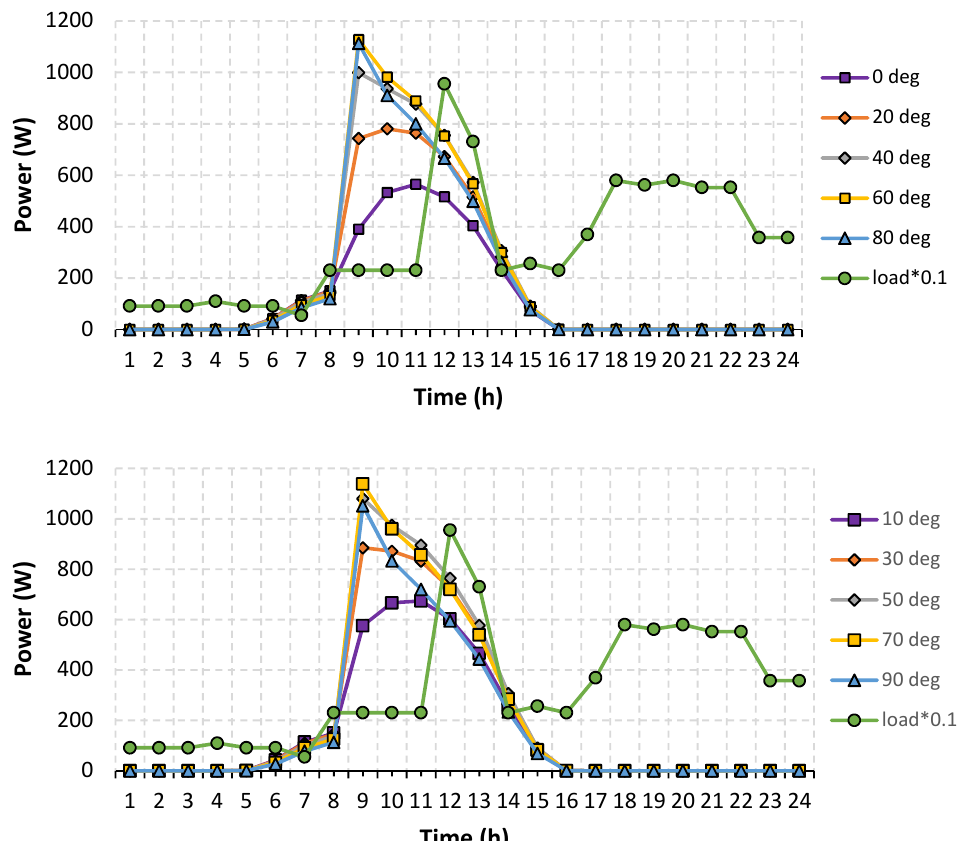
Figure 8. Tilt angle impact for solar power: upper the first group angles, and lower the second group. Consequently, the corresponding global tilted solar irradiance is utilized in Equa- tion (1) to help achieve the current technoeconomic study. The impact of the azimuth angle is demonstrated in Figure 9.